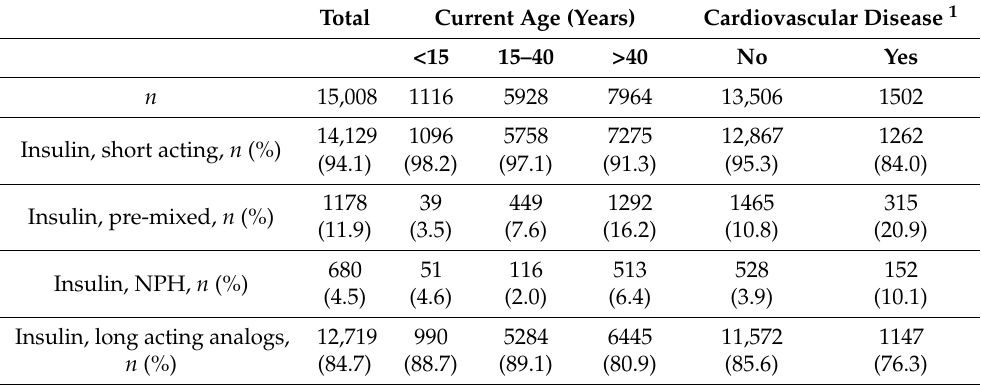
Table 3. Current insulin therapy for patients with T1D stratified by age group and presence of cardiovascular disease.